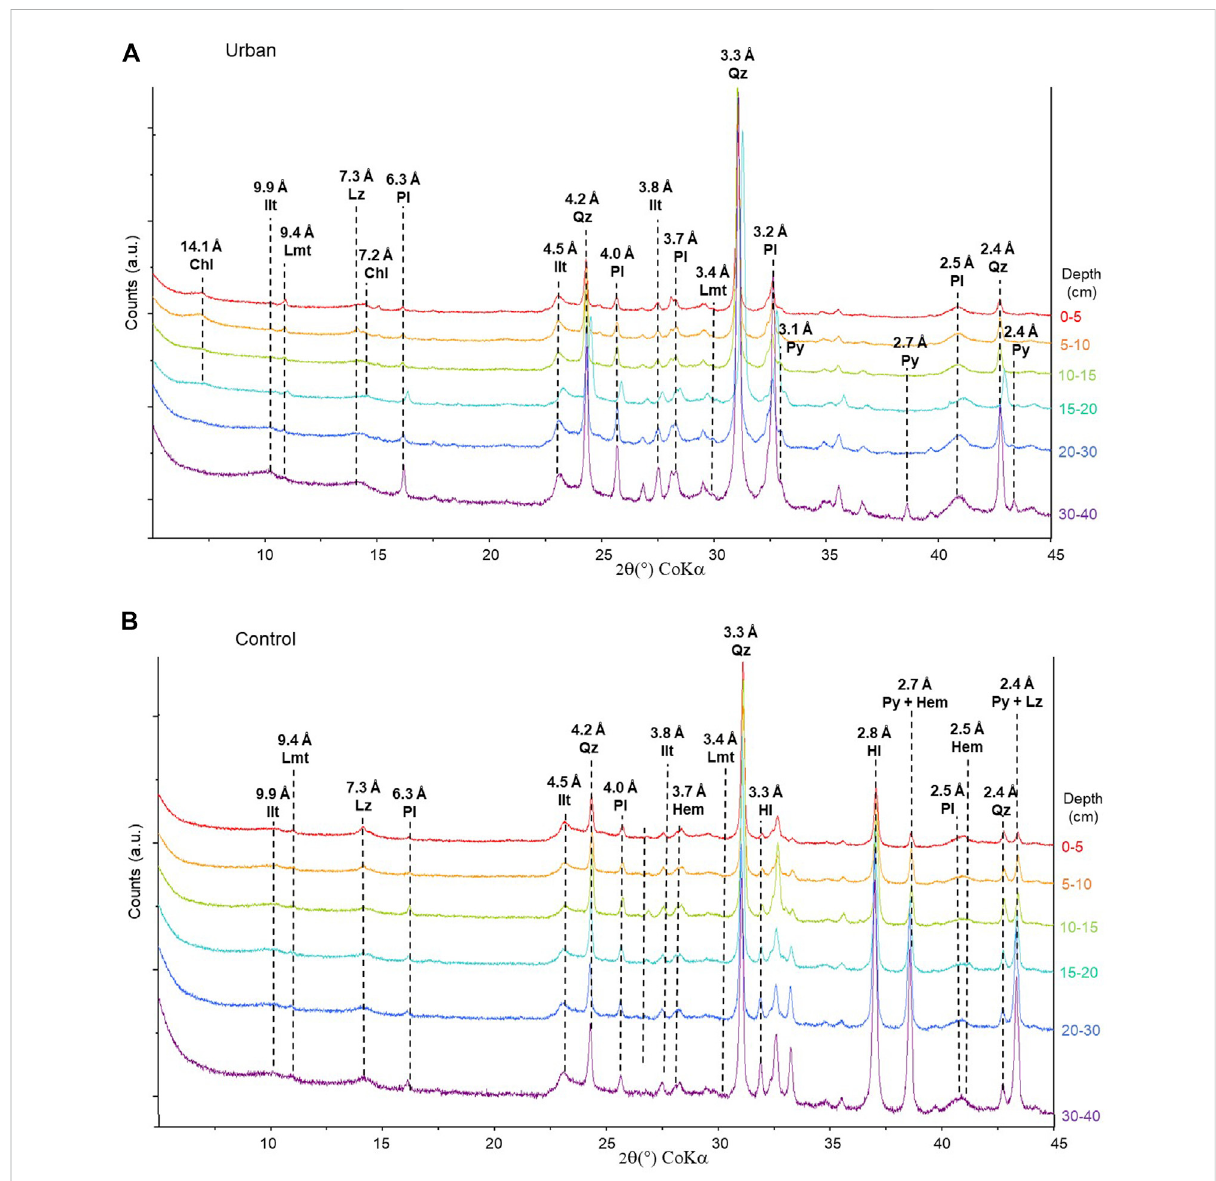
FIGURE 3 XRD diffractograms of the (A) urban site and (B) control site along soil core with depth and characteristic peaks labelled in d-spacing (Å). Chl – Chlorite, Hl – Halite, Hem – Hematite, Ilt – Illite, Lmt – Laumontite, Lz – Lizardite, Pl – Plagioclase, Py – Pyrite, Qz –